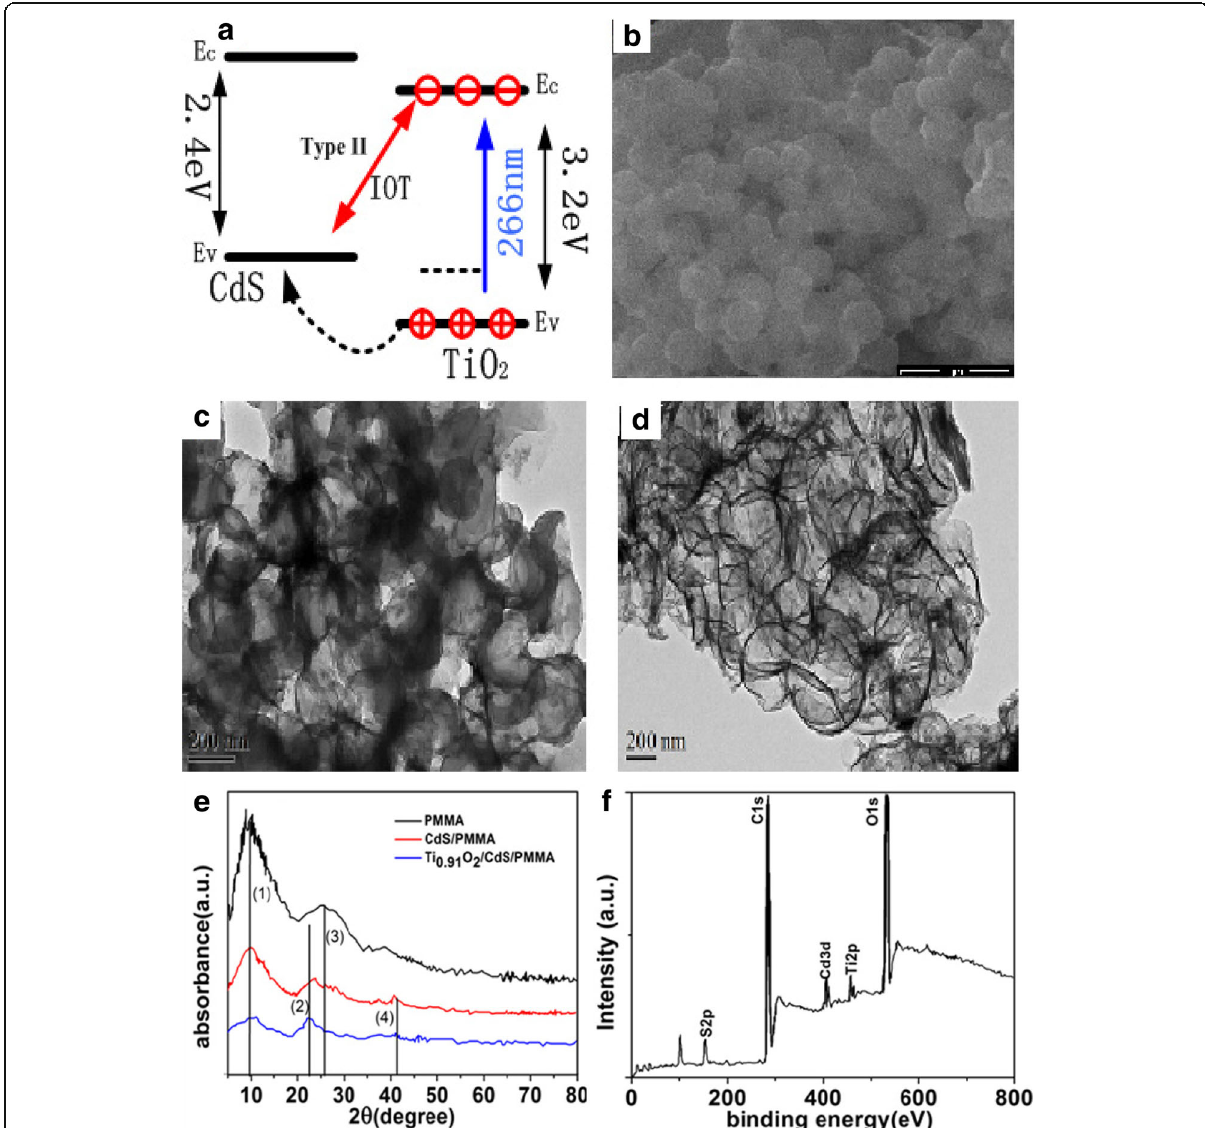
Fig. 1 a Energy band diagram of hybrid spheres Ti 0.91 O 2 and CdS. b Scanning electron microscopy (SEM) images of Ti 0.91 O 2 /CdS. c Transmission electron microscopy (TEM) images of the solid Ti 0.91 O 2 /CdS hybrid spheres. d Hollow Ti 0.91 O 2 /CdS hybrid spheres. e XRD of PMMA, CdS, and Ti 0.91 O 2 / CdS. f XPS spectrum of Ti 0.91 O 2